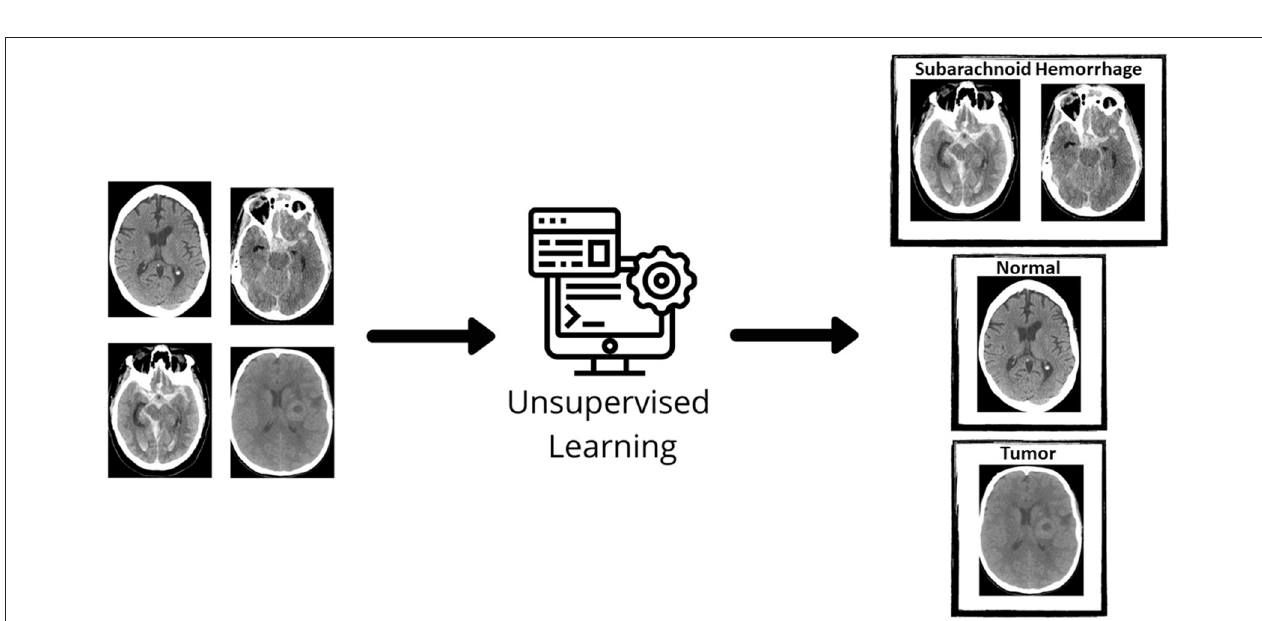
FIGURE 2 | Unsupervised learning. In unsupervised learning, the machine learning algorithm discovers structures within given data. The initial data is not labeled and a clustering algorithm groups unlabeled data together. Source: WesternDigital BLOG.